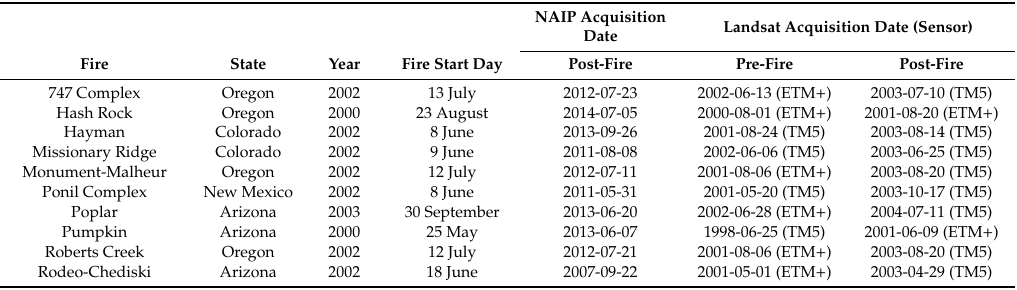
Table 1. Summary of fire start dates and imagery acquisition dates used for mapping and analysis. Imagery was obtained from the National Agricultural Imagery Program (NAIP), Landsat Thematic Mapper (TM) and the Enhanced Thematic Mapper Plus (ETM +